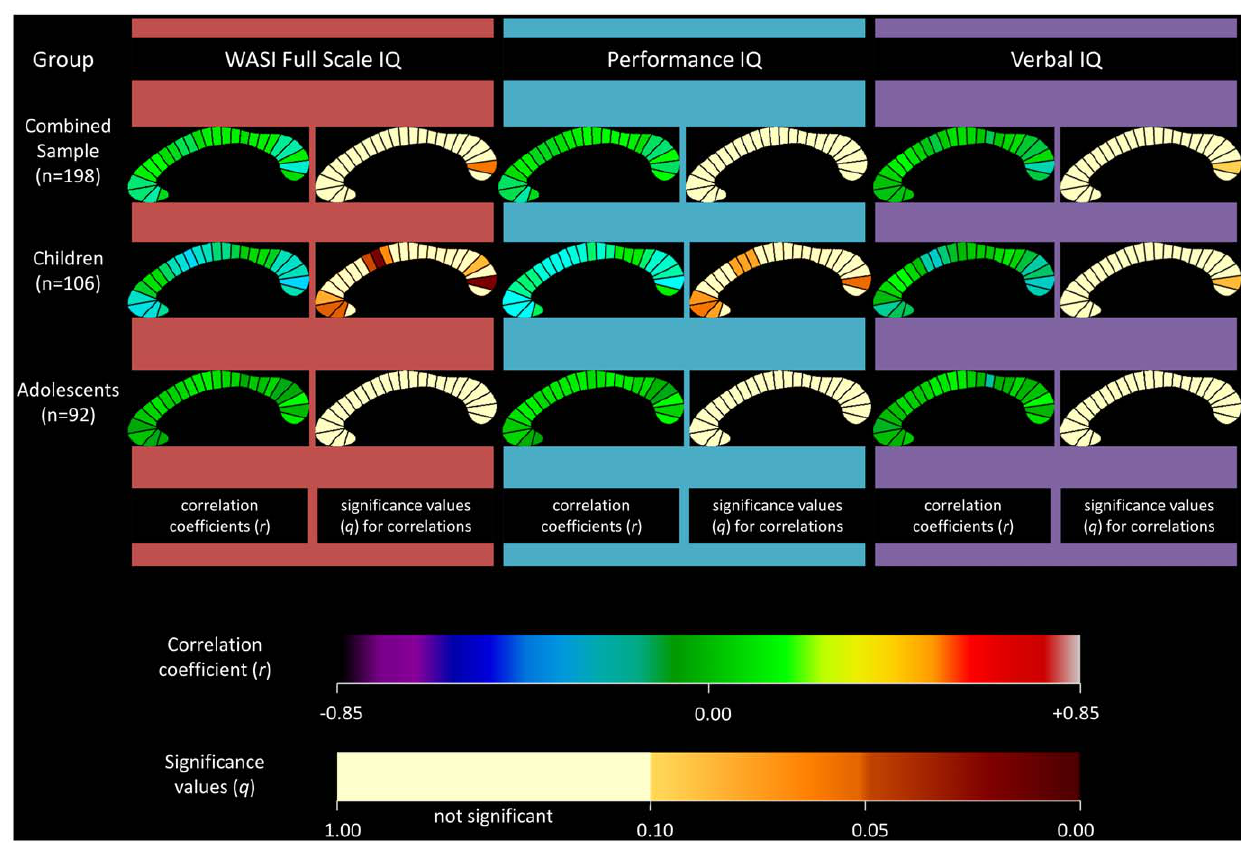
Figure 4. Correlations between corpus callosum midsagittal area and IQ: combined sample and sample partitioned by age. Partial correlation coefficients and associated significance values for Full-Scale IQ measurements are shown in the first and second columns of callosal maps. Correlation coefficients and associated significant values for Performance IQ are shown in the third and fourth columns, and for Verbal IQ in the fifth and sixth columns. The combined sample is shown in the first row, the children in the second row, and the adolescents in the third row. The upper color bar encodes the r -values that depict the magnitude and direction of correlations, and the lower color bar encodes the level of significance.